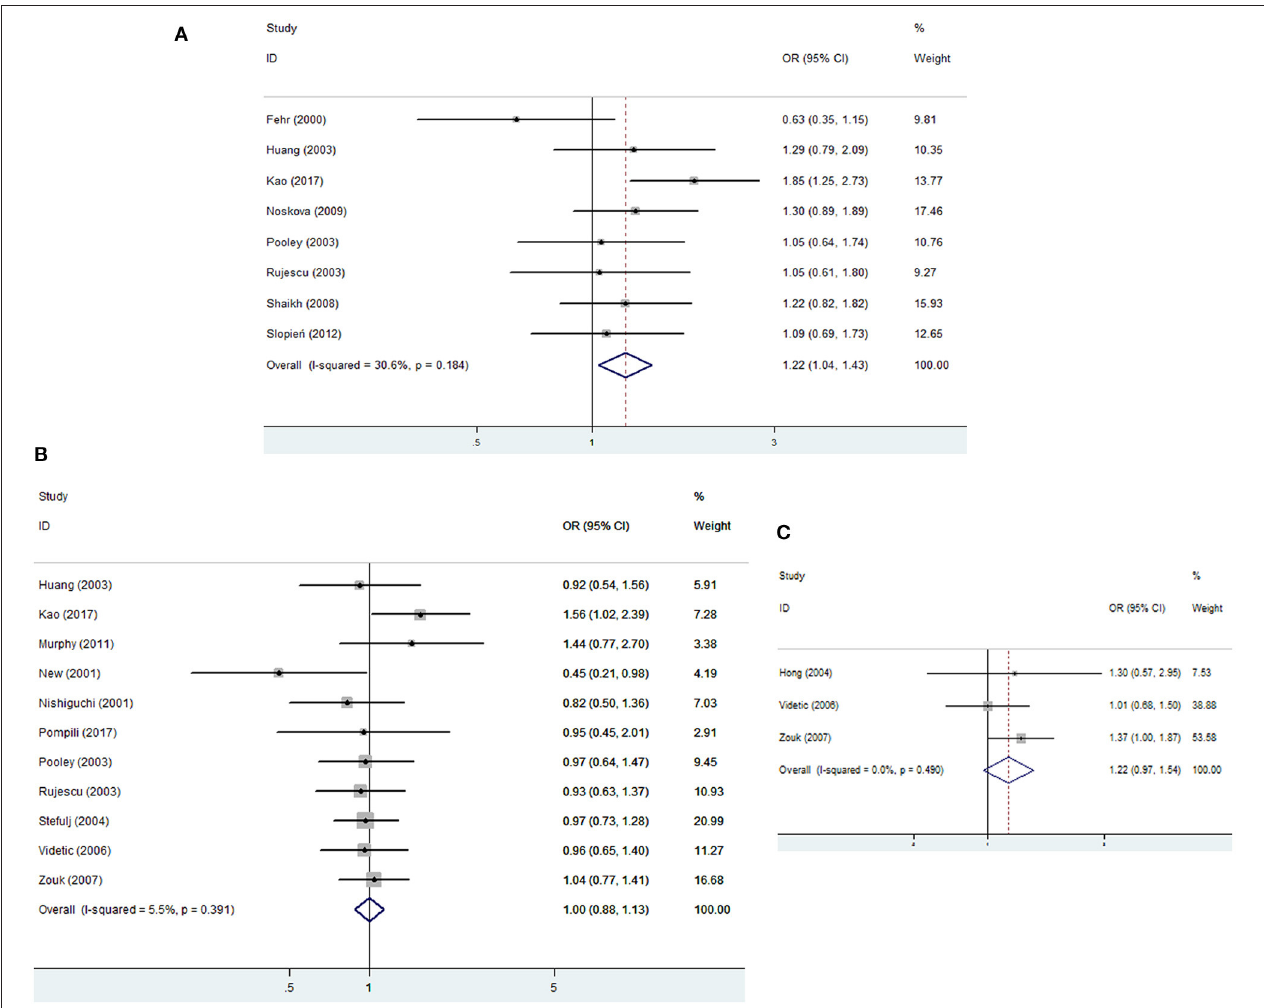
FIGURE 2 | Meta-analysis of HTR1B polymorphisms with the risk of MDD and suicidal behavior. (A) rs6296 polymorphism and MDD risk; (B) rs6296 polymorphism and the risk of suicidal behavior; (C) rs130058 polymorphism and the risk of suicidal behavior. A fixed effects model was used under a dominant model.